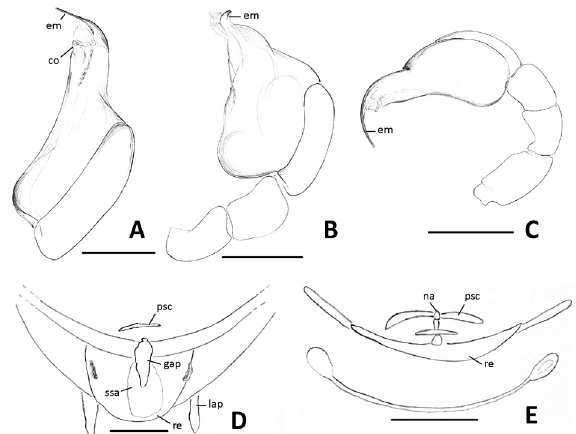
Figure 20. Silhouettella snippy n. sp. ( A, D ), Silhouettella tiggy n. sp. ( B ), Silhouettella saaristoi n. sp. ( C, E ): A–C , male left palp, retrolateral view; D , female epigastric region, dorsal view; E , same. Abbreviations: em , embolus; gap , globular appendix; lap , lateral apodemes na , nail like process; psc , paddle-like sclerite; re , receptaculum; ssa , secretory sac. Scale bars: 0.1 mm.